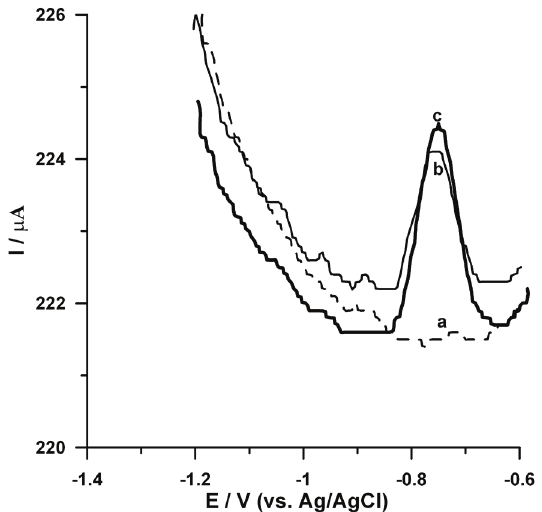
Figure 1: Square wave voltammograms obtained at the in situ plated lead film electrode prepared without (a and b) and with (c) the use of a zinc mediator. The solution for electrode preparation and Cd(II) determination contained 0.1 mol L -1 acetate buffer pH = 4.6 ± 0.1, 5 × 10 -6 mol L -1 Pb(II), 0 (a) or 5 × 10 -7 mol L -1 Cd(II) (b and c) and 0 (a and b) or 1 × 10 -5 mol L -1 (c) Zn(II). Zn, Pb and Cd were deposited at -1.5 V for 120 s. The potential and time of zinc oxidation and further deposition of lead and cadmium were -0.95 V and 120 s, respectively.